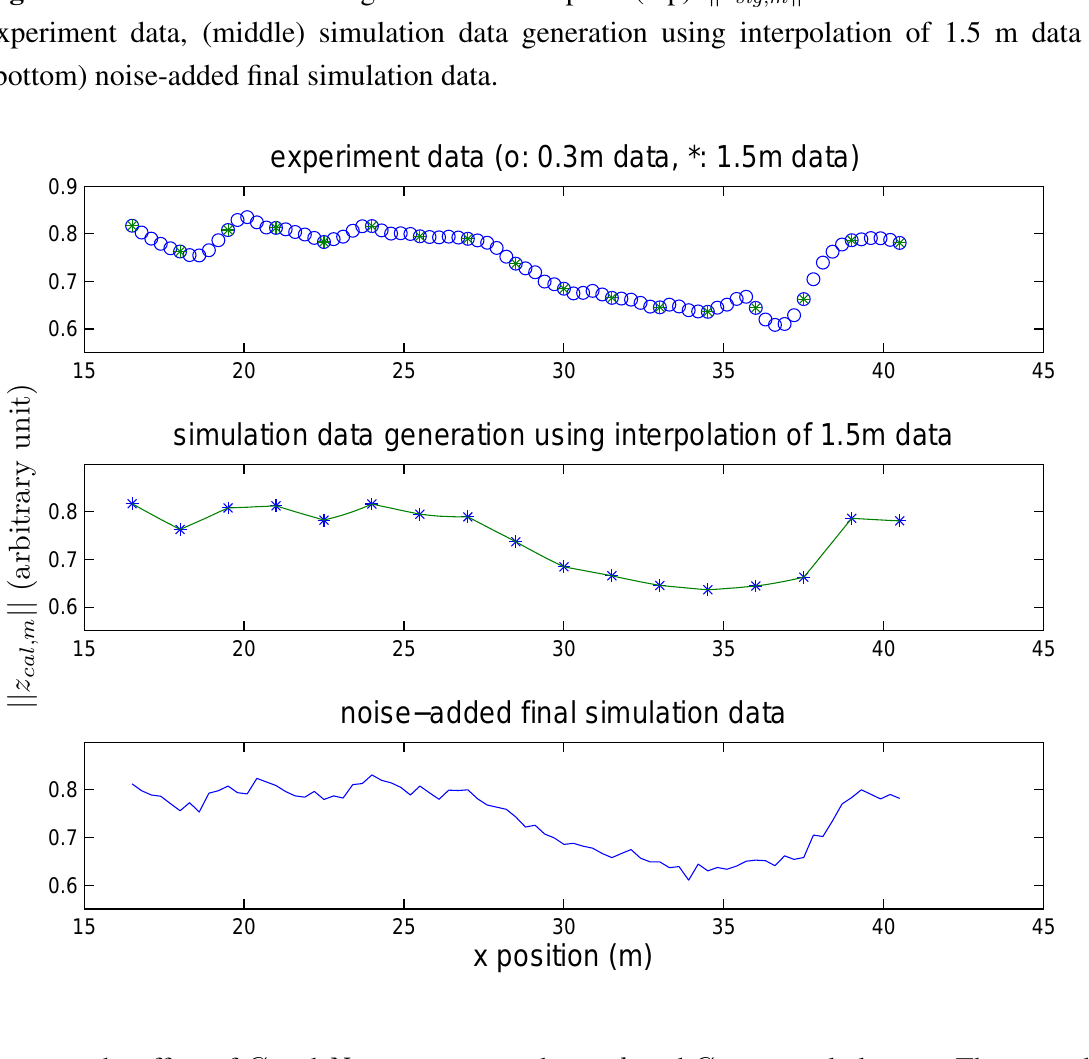
∥ with 0.3 m cell size sig;m